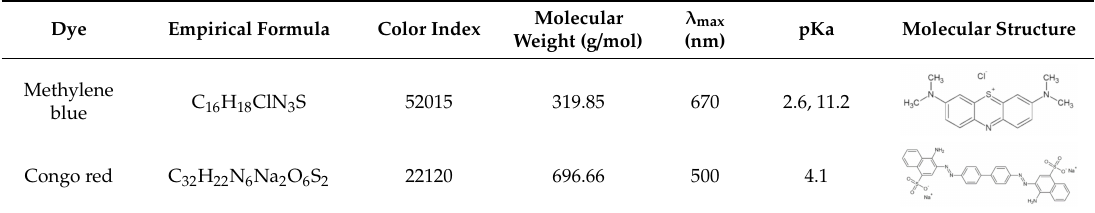
Table 1. Characteristics of methylene blue and congo red used in the current